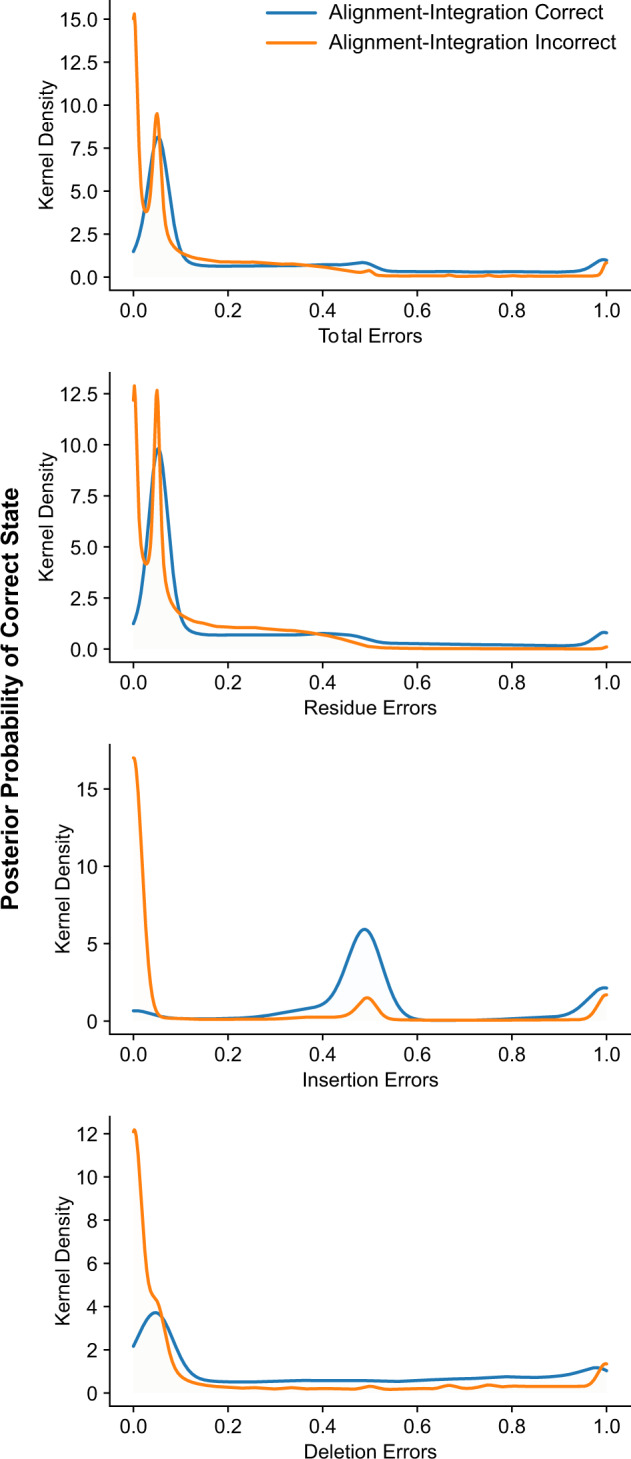
Alignment–integration can “repair” ASR errors when the correct ancestral state is not strongly disfavored across sequence-alignment methods. We simulated protein sequences along a three-taxon phylogeny, varying the branch length and indel rate (see supplementary fig. S12, Supplementary Material online). Ancestral sequences were inferred using seven sequence-alignment methods and alignment–integration. Total- (top), residue-, insertion-, and deletion- (bottom) errors were calculated by comparing inferred ancestral sequences to the correct ancestral sequence. Here, we consider only those cases in which a single sequence-alignment method produces an ASR error, and the majority of alternative sequence-alignment methods do not infer the correct ancestral state. We further divide such cases into 1) errors that are “repaired” by alignment–integration (blue) and 2) errors that are not repaired by alignment–integration (orange). Under each scenario, we estimate the frequency distribution of the PP of the correct ancestral state by kernel density estimation.